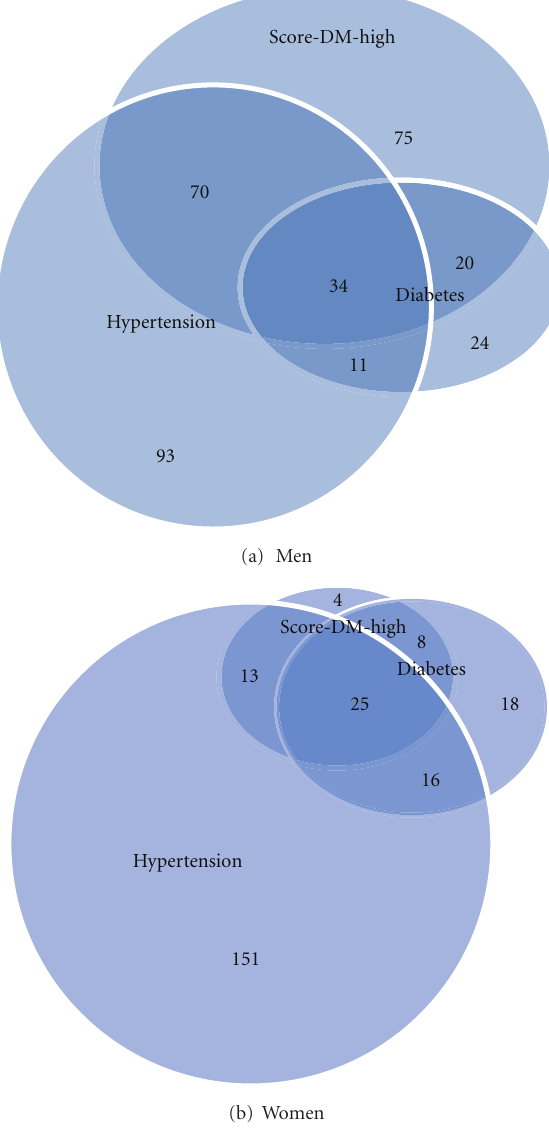
Figure 2: Venn diagrams in men (a) and women (b), showing the overlap between categories of hypertension, diabetes, and high risk score, respectively, accounting for (4)